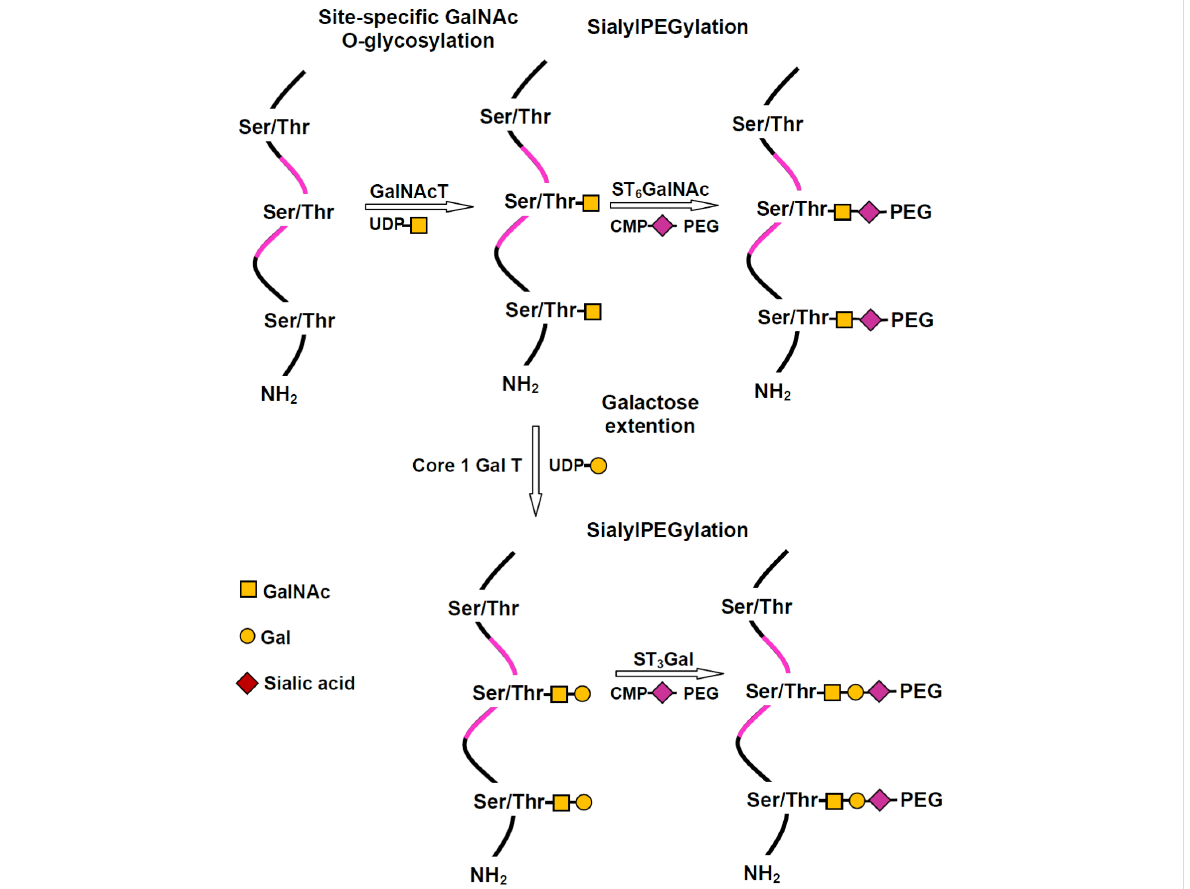
Scheme 2: GlycoPEGylation by sequential in vitro, enzyme mediated, O -glycosylation followed by transfer of PEGylated sialic acid, adapted from [31].